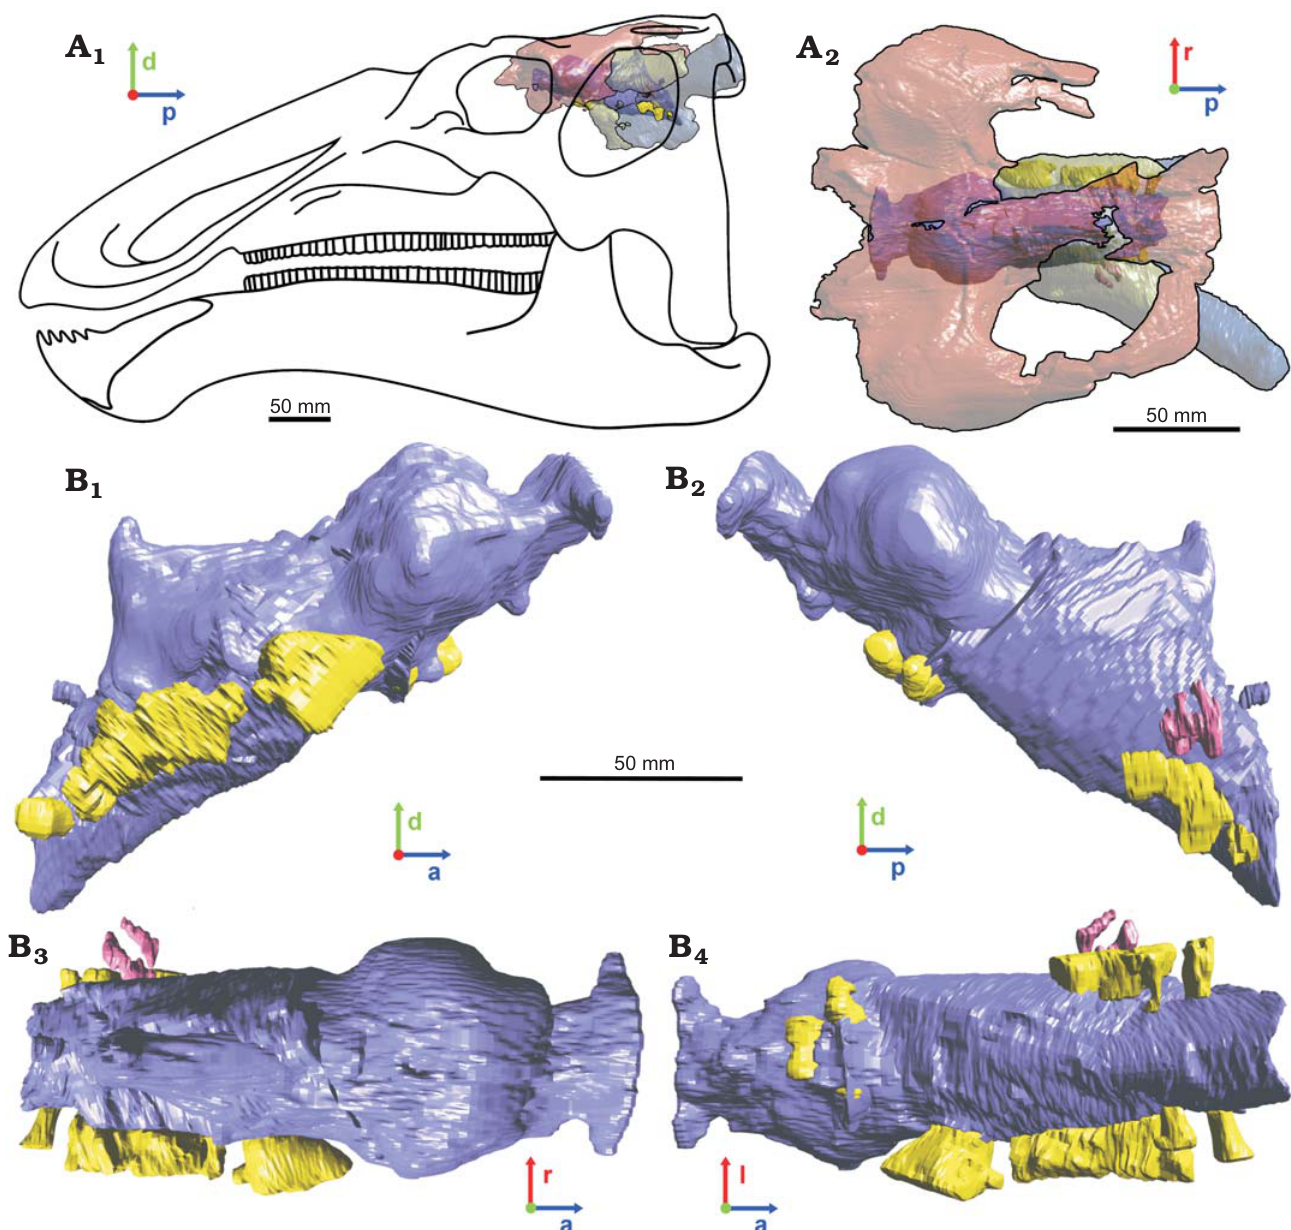
Fig. 6. 3D-reconstructed endocast based on the information of the studied specimens representing the brain morphology of the hadrosaurid dinosaur Secernosaurus koerneri Brett-Surman, 1979 from the late Campanian–early Maastrichtian, Los Alamitos Formation of North Patagonia. A . Braincase and endocasts in 3D positioned over a line drawing reconstruction of the skull in left lateral view; based on the mounted skeletons at the MACN (size for the line drawing is estimative). B . Dorsal view of the 3D specimens MACN-RN 144 (transparent red), MACN-RN 143 (transparent green) and MACN-RN 02 (transparent blue) in order from left to right and as they were positioned to compile the final endocranial reconstruction. C . Final endocast reconstruction in right (C 1 ) and left (C 2 ), dorsal (C 3 ), and ventral (C 4 ) views. The anatomical labelling was presented in former figures. Blue, encephalon; pink, inner ear; yellow, foramina of the cranial nerves. Abbreviations: a, anterior; d, dorsal; l, left; p, posterior; r, right. All specimens with their 3D endocasts are presented as a 3D pdf in the